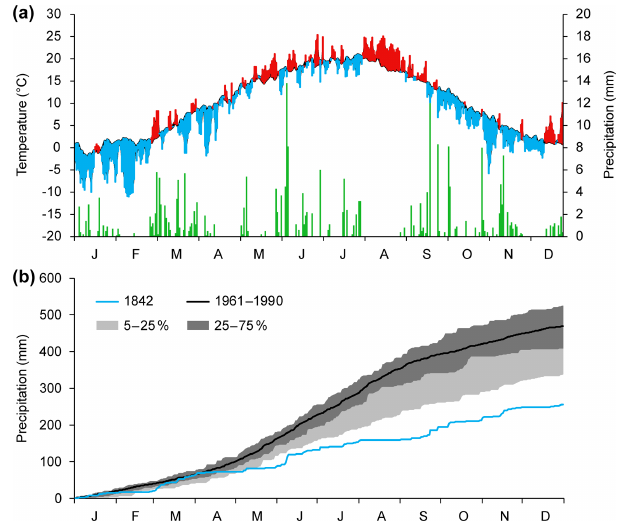
Figure 4. Temperature and precipitation for 1842 at the Prague- Klementinum station: (a) annual variation in daily mean temper- atures (compared with the 1961–1990 mean variation) and daily precipitation totals for 1842; (b) cumulative daily precipitation to- tals for 1842 in comparison with the 1961–1990 reference period (the interquartile (75%–25%) and lower quartile to 5th percentile (25%–5%) bands of the 1961–1990 period are